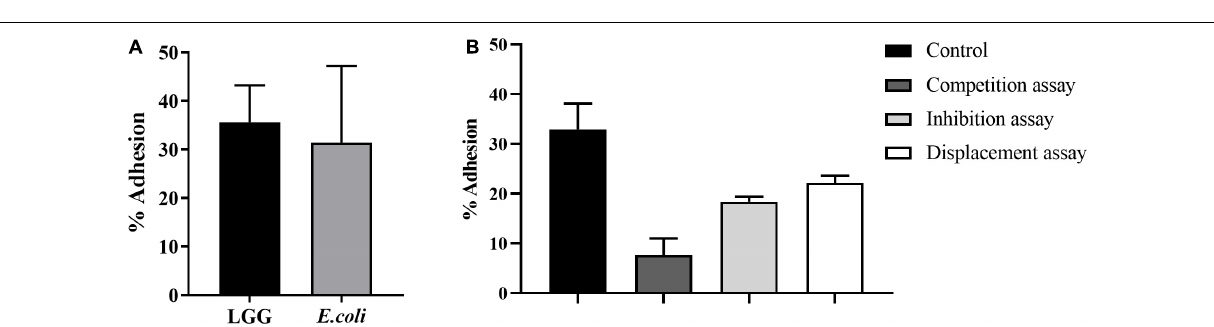
FIGURE 2 | Effects of LGG on E. coli adhesion to primary chicken intestinal epithelial cells. (A) The LGG and E. coli cultures were added to primary chicken intestinal epithelial cells (MOI = 100:1), followed by 1-h incubation at 37 ◦ C and 5% CO 2 . Adhesion percentage of LGG and E. coli to primary chicken intestinal epithelial cells was expressed as the number of adherent bacteria relative to the total number of bacteria. (B) Competition, inhibition, and displacement of E. coli adhesion in the presence of LGG. LGG and E. coli (1:1) were simultaneously added to primary chicken intestinal epithelial cells for competition assay. In the inhibition assay, LGG was first added to primary chicken intestinal epithelial cells and incubated for 1 h, after which unbound LGG was removed and E. coli was added to the wells. On the contrary, in the displacement assay, E. coli was added first. Bars represent the means ± standard deviations of three independent